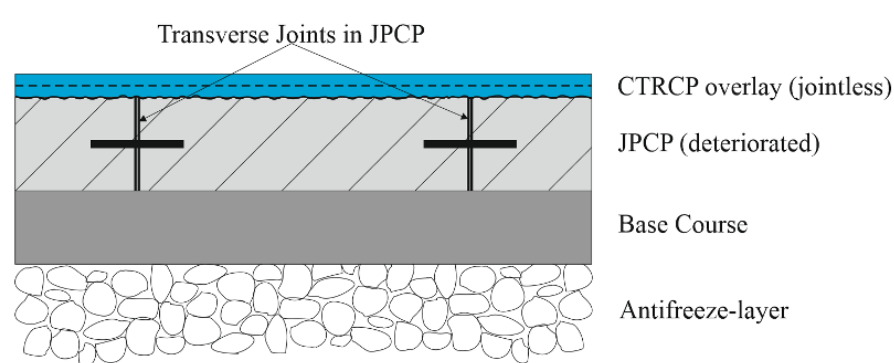
Figure 1. Schematic construction of a jointless Carbon Textile Reinforced Concrete Pavement (CTRCP) overlay on a deteriorated JPCP bottom-layer (jointed).